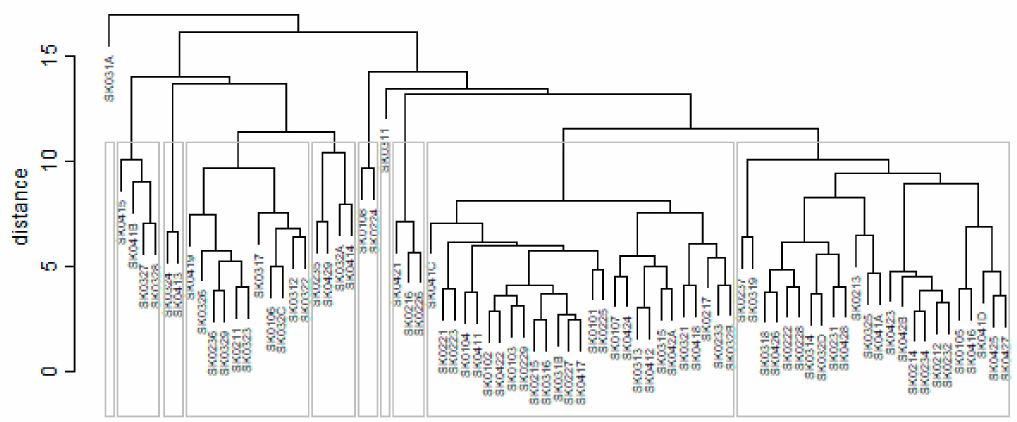
Figure 22. Preventable mortality dendrogram of the districts for the male sex in the year 2008. Source: own elaboration by the authors.